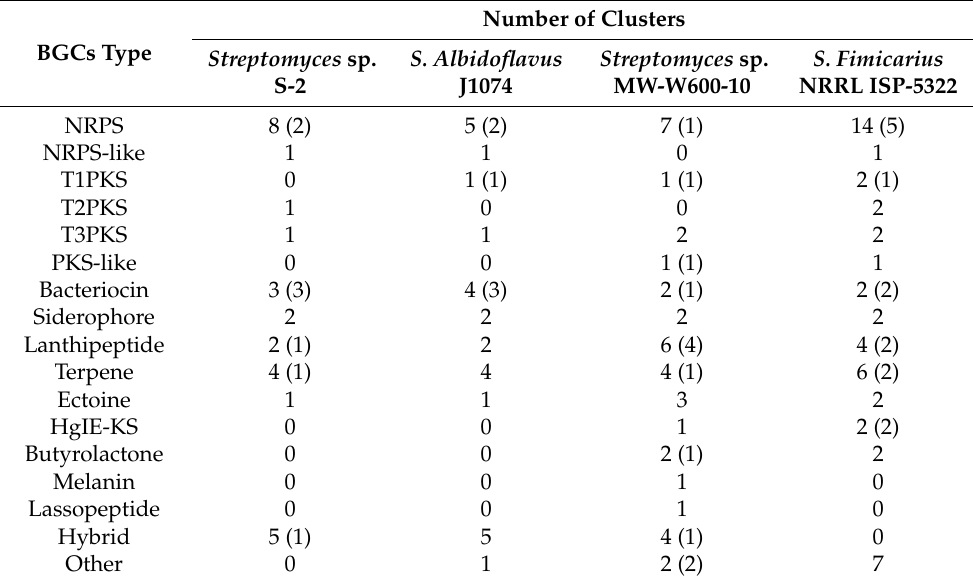
Table 2. Comparison of BGCs composition of coal-related Streptomyces strains and their closest phylogenetical